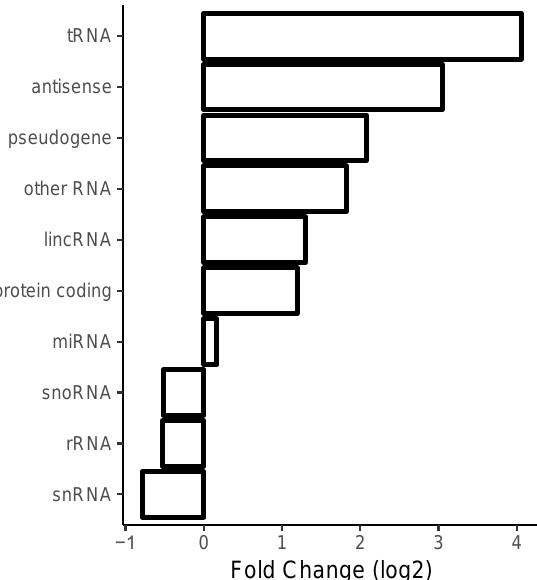
Figure 3. Enrichment of formation of long contiguous duplexes with respect to the removal of proteins. Upon the removal of proteins, most RNA classes such as transfer RNA (tRNA), antisense RNAs, messenger RNAs (mRNAs), and long intergenic non-coding RNA (lincRNA) genes were more likely to exhibit duplex formation, while ribosomal RNAs tended to be less structured. The gene class nomenclature follows the gene classification provided by ENSEMBL with the exception that a variety of subtypes of pseudogenes were combined into one “pseudogene” class.